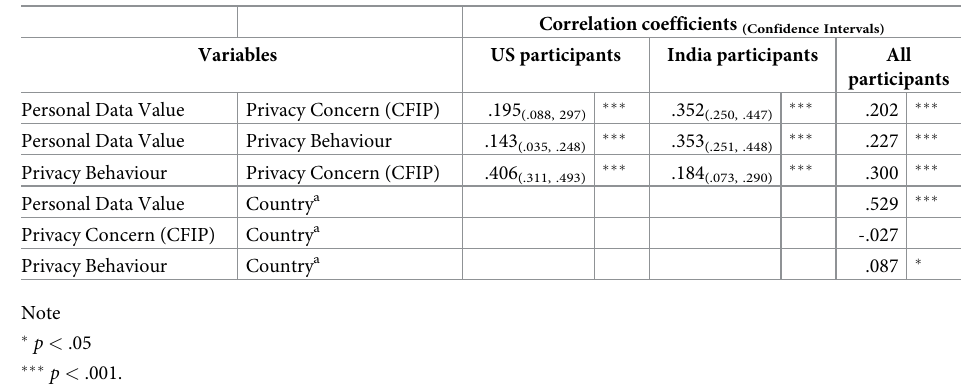
Table 3. Correlation coefficients for research variables in Study 1b.